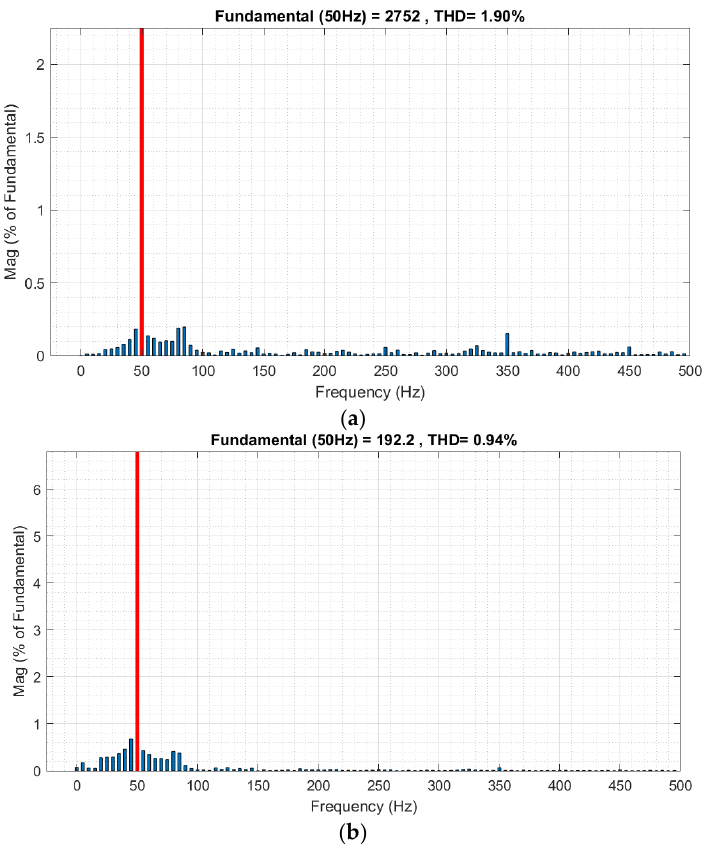
Figure 8. ( a ) FFT analysis of the three − phase output voltage. ( b ) FFT analysis of the three − phase output current.